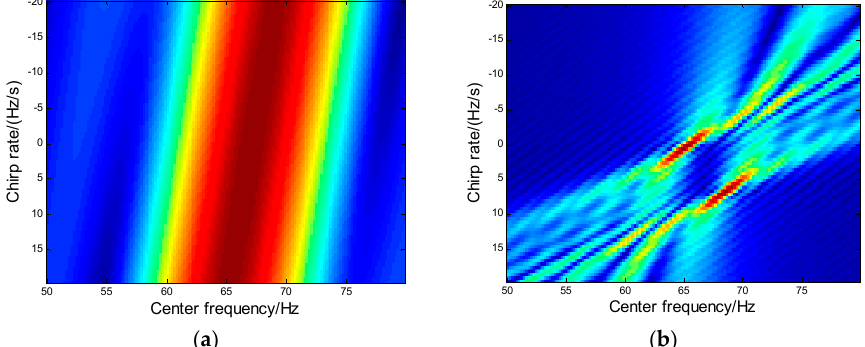
Figure 7. The second-order PFT result in f 2 − f 1 plane. ( a ) Coherent time T = 0.1 s; ( b ) Coherent time T = 0.8 s.